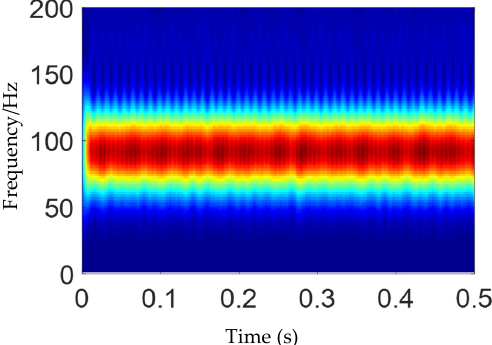
Figure 16. Time – frequency distribution obtained by GLCT method.